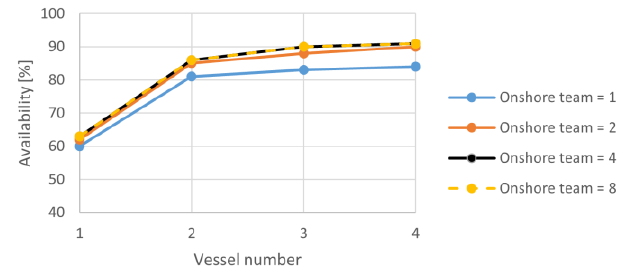
Fig. 17. Farm availability versus vessel number for various numbers of onshore teams, in the case of c/d time=1 hr and assembly team=3.